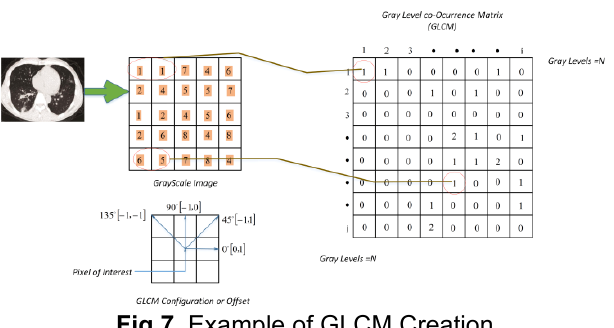
Fig 7. Example of GLCM Creation